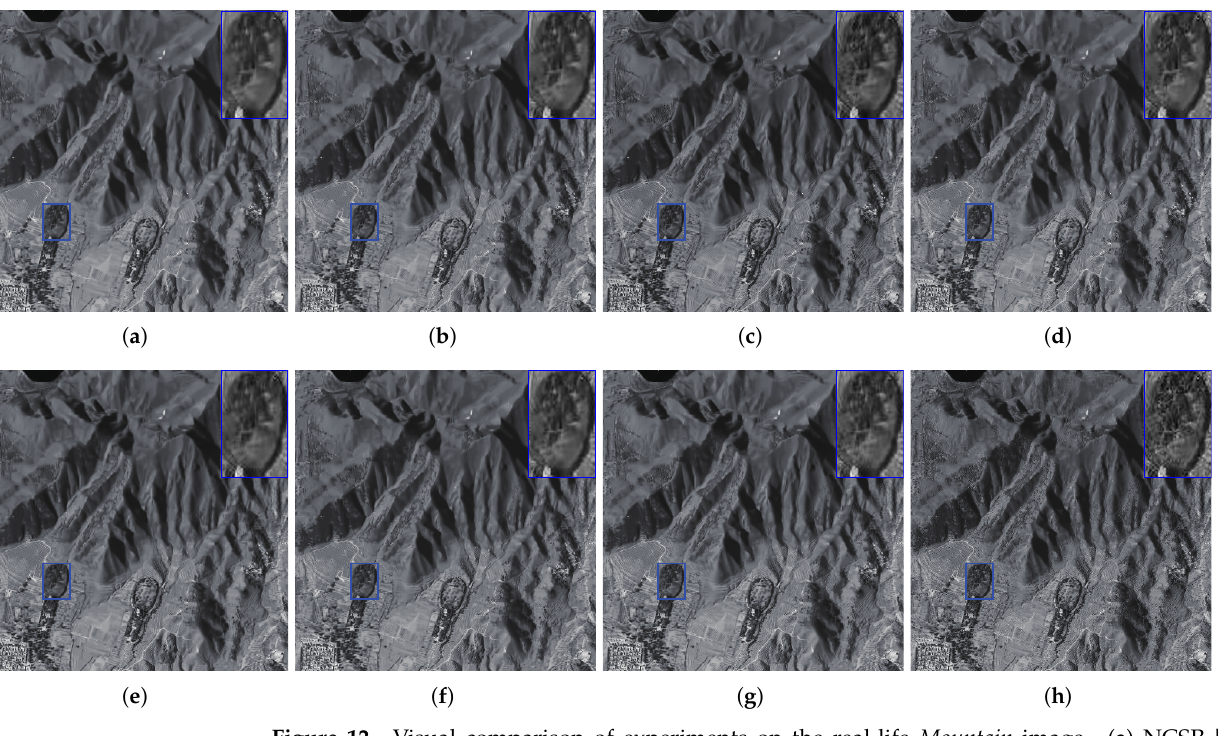
Figure 12. Visual comparison of experiments on the real-life Mountain image. ( a ) NCSR [43]. ( b ) WSSR [6]. ( c ) DnCNN [18]. ( d ) DKSVD [68]. ( e ) DCDicL [73]. ( f ) LRR-CNN [74]. ( g ) DLRP [75]. ( h ) Proposed.